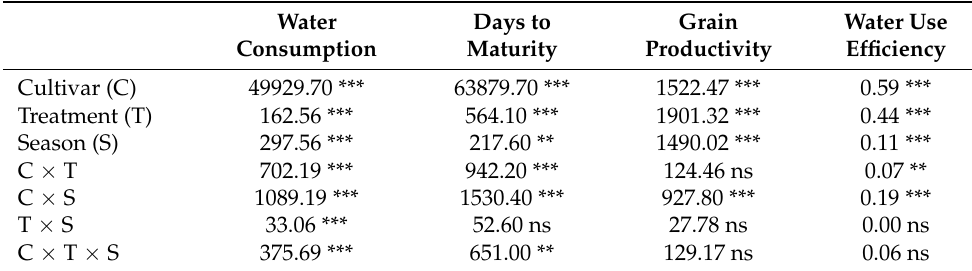
Table 2. Maturity duration (days) of lowland rice cultivars under control and drought stress treat- ments during first season (A) and second season (B) [5].